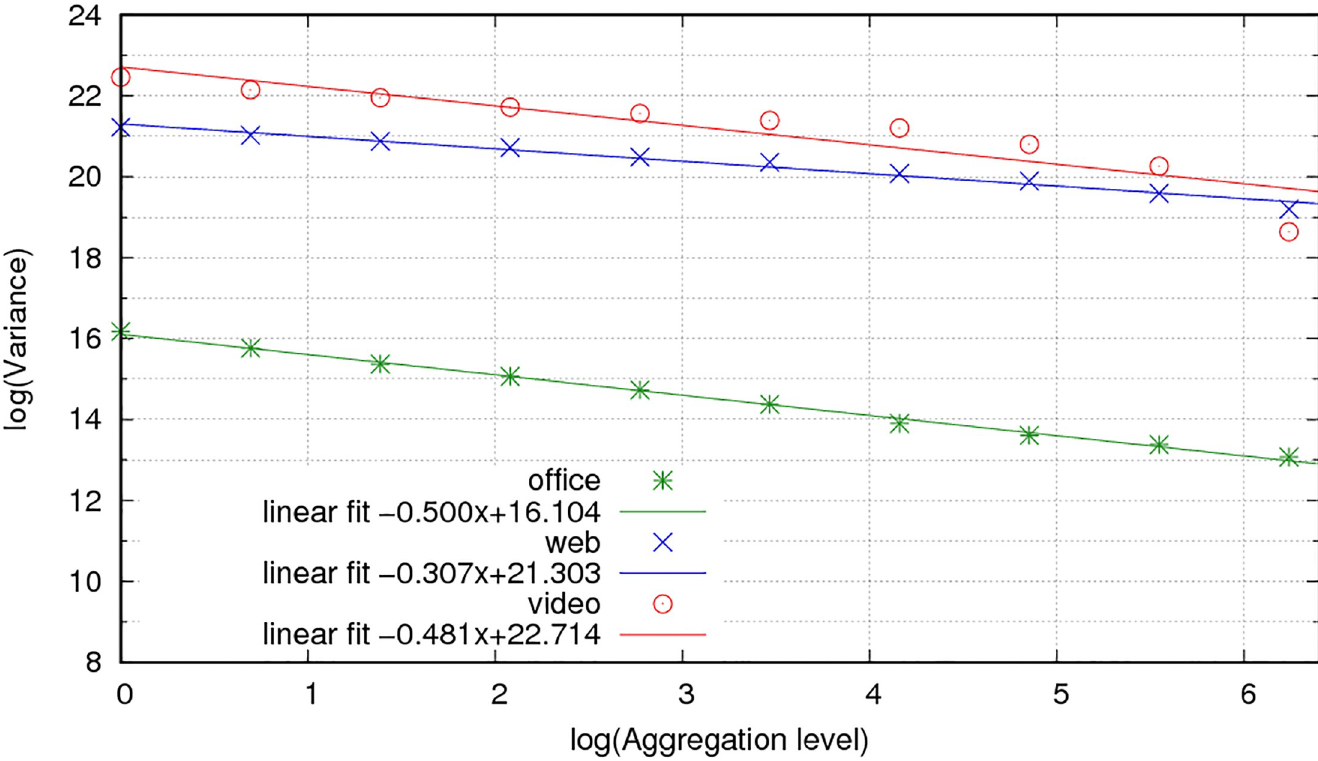
Fig 9. Variance aggregation plot for PCoIP traffic.